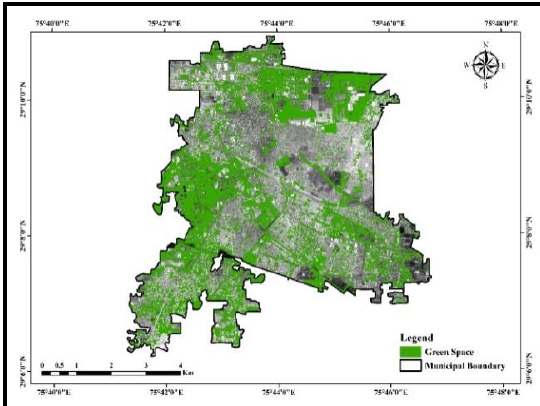
Figure 4. Green Space obtained by on screen digitization